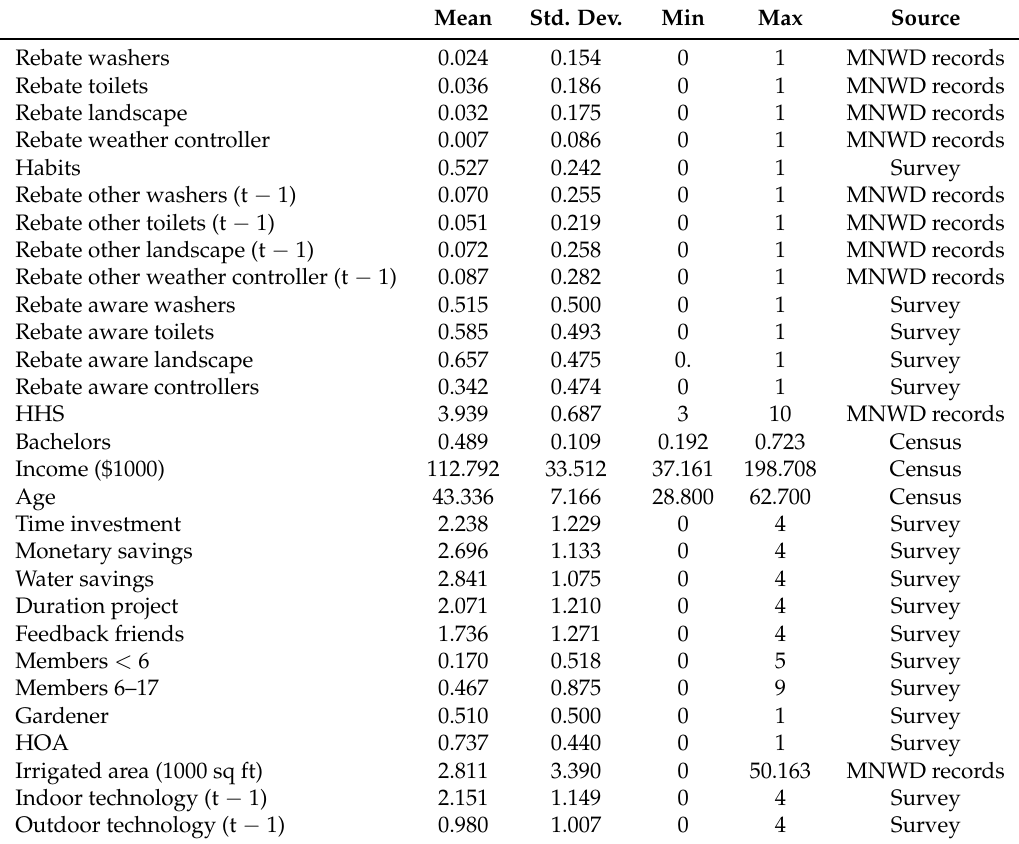
Table 1. Summary statistics—propensity score matching.